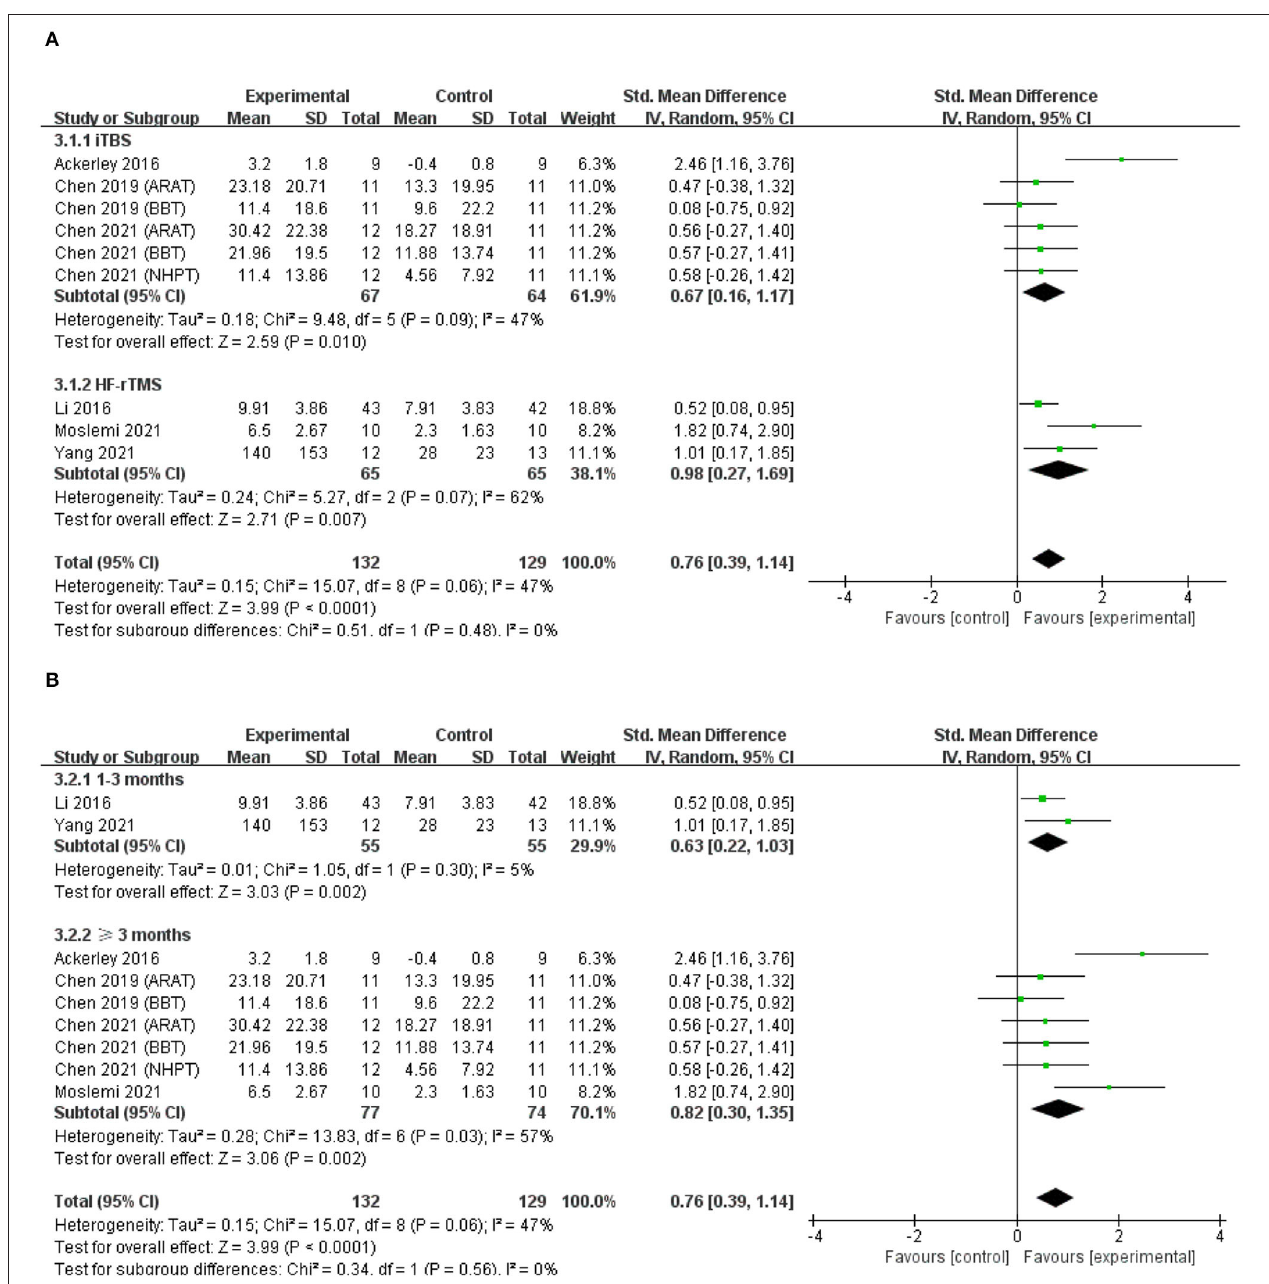
FIGURE 5 | (A) Forest plot from the meta-analysis of excitatory rTMS on hand dexterity showing estimates of effect size (SMD) with 95% confidence intervals: subgroup analysis based on different types of rTMS. (B) Forest plot from the meta- analysis of excitatory rTMS on hand dexterity showing estimates of effect size (SMD) with 95% confidence intervals: subgroup analysis based on the duration post-stroke.